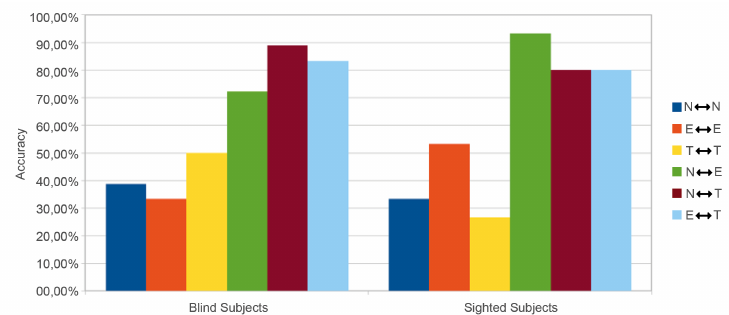
Figure 16. Accuracy by category - amplitude set at 55.